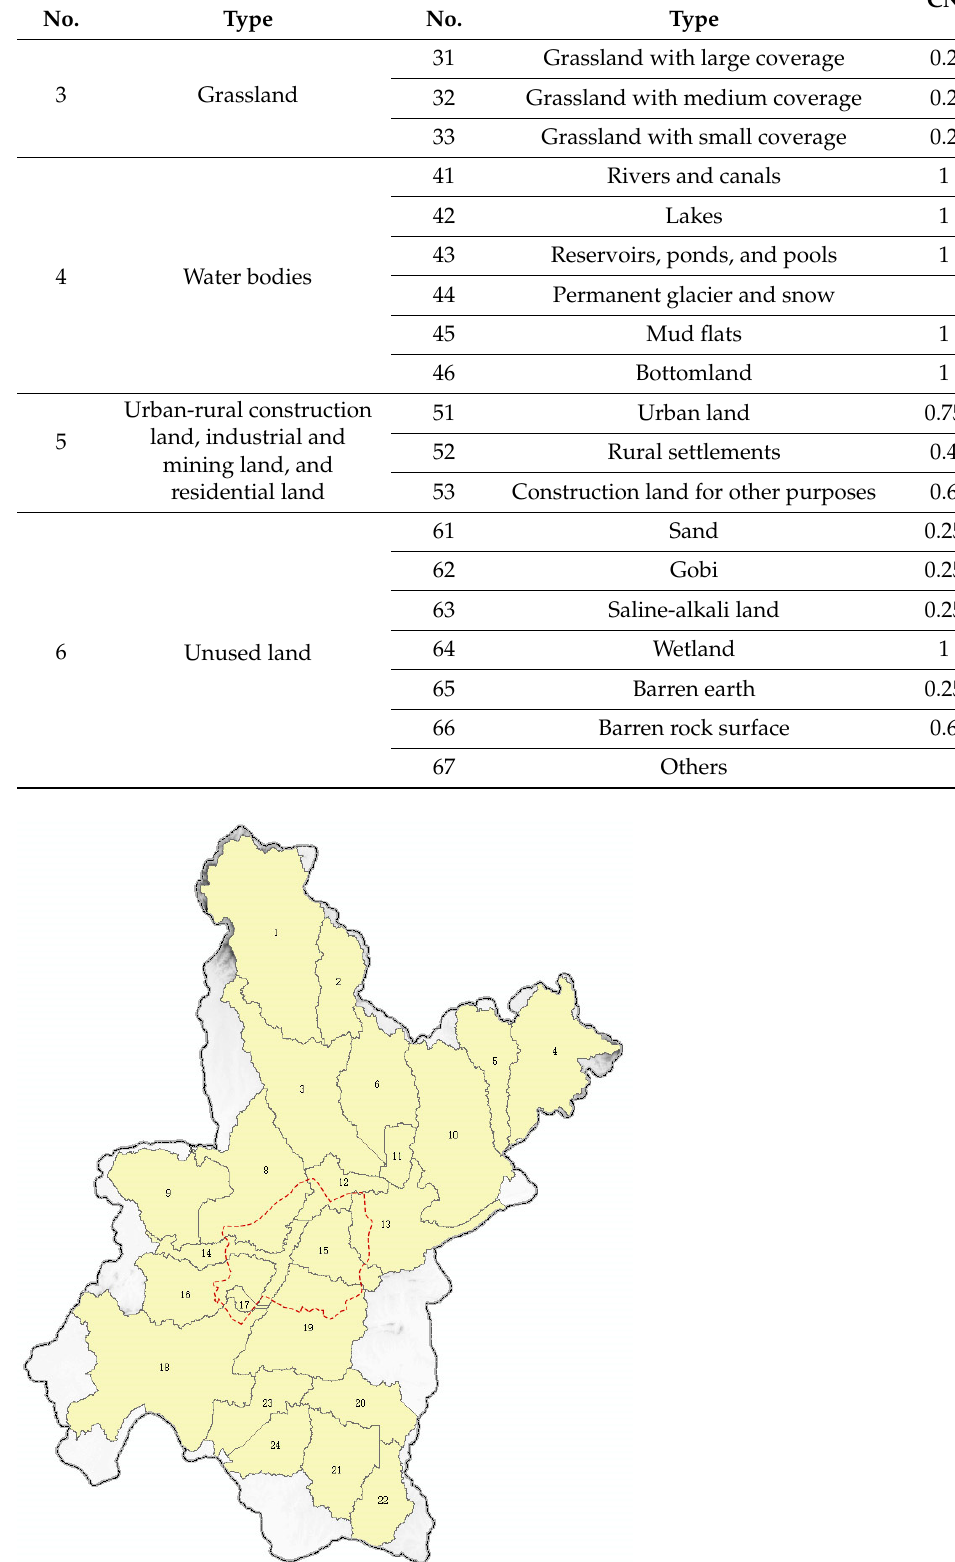
Figure A1. Simulation results and serial map of watershed division and submergence in Wuhan city. Table A3. List of results of SCS-CN model.